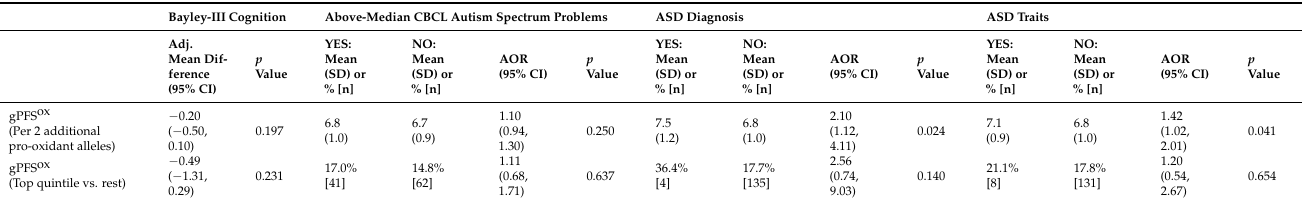
Table 3. Main effect of genetic pathway function score for oxidative stress response (gPFS ox ) against cognitive and ASD